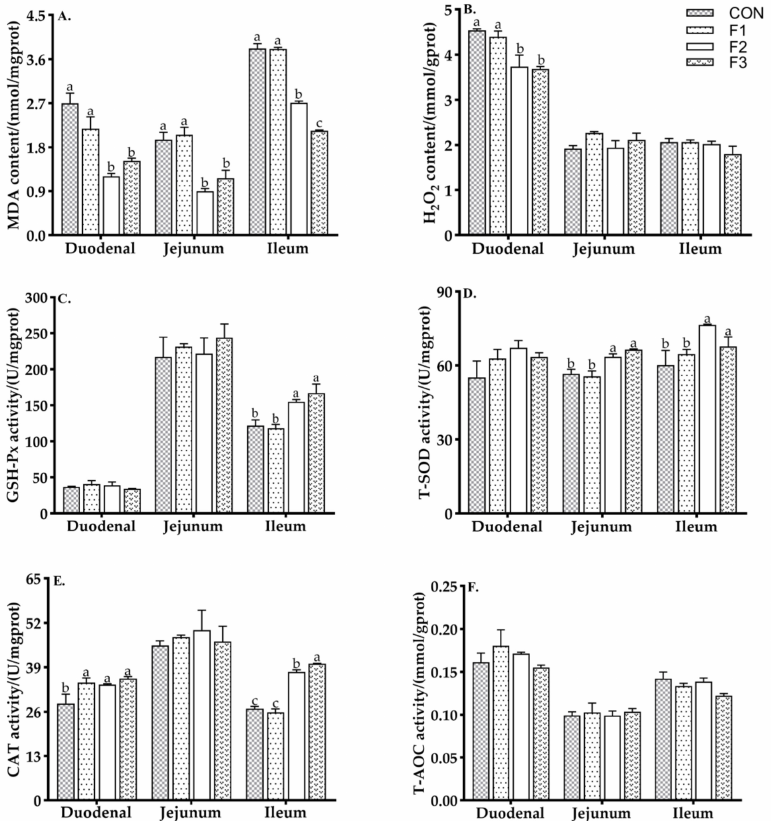
Figure 2. Effects of dietary fucoidan supplementation on intestinal mucosa antioxidant capacity in weaned goat kids. ( A ) MDA content; ( B ) H 2 O 2 content; ( C ) GSH-Px activity; ( D ) T-SOD activity; ( E ) CAT activity; ( F ) T-AOC activity. Results are presented as mean ± SEM. a–c means significantly different ( p < 0.05). CON, basal diet; F1, basal diet + 0.1% fucoidan; F2, basal diet + 0.3% fucoidan; F3, basal diet + 0.5% fucoidan. MDA, malondialdehyde; H 2 O 2 , hydrogen peroxide; GSH-Px, Glutathione peroxidase; T-SOD, total superoxide dismutase; CAT, catalase; T-AOC, total antioxidant